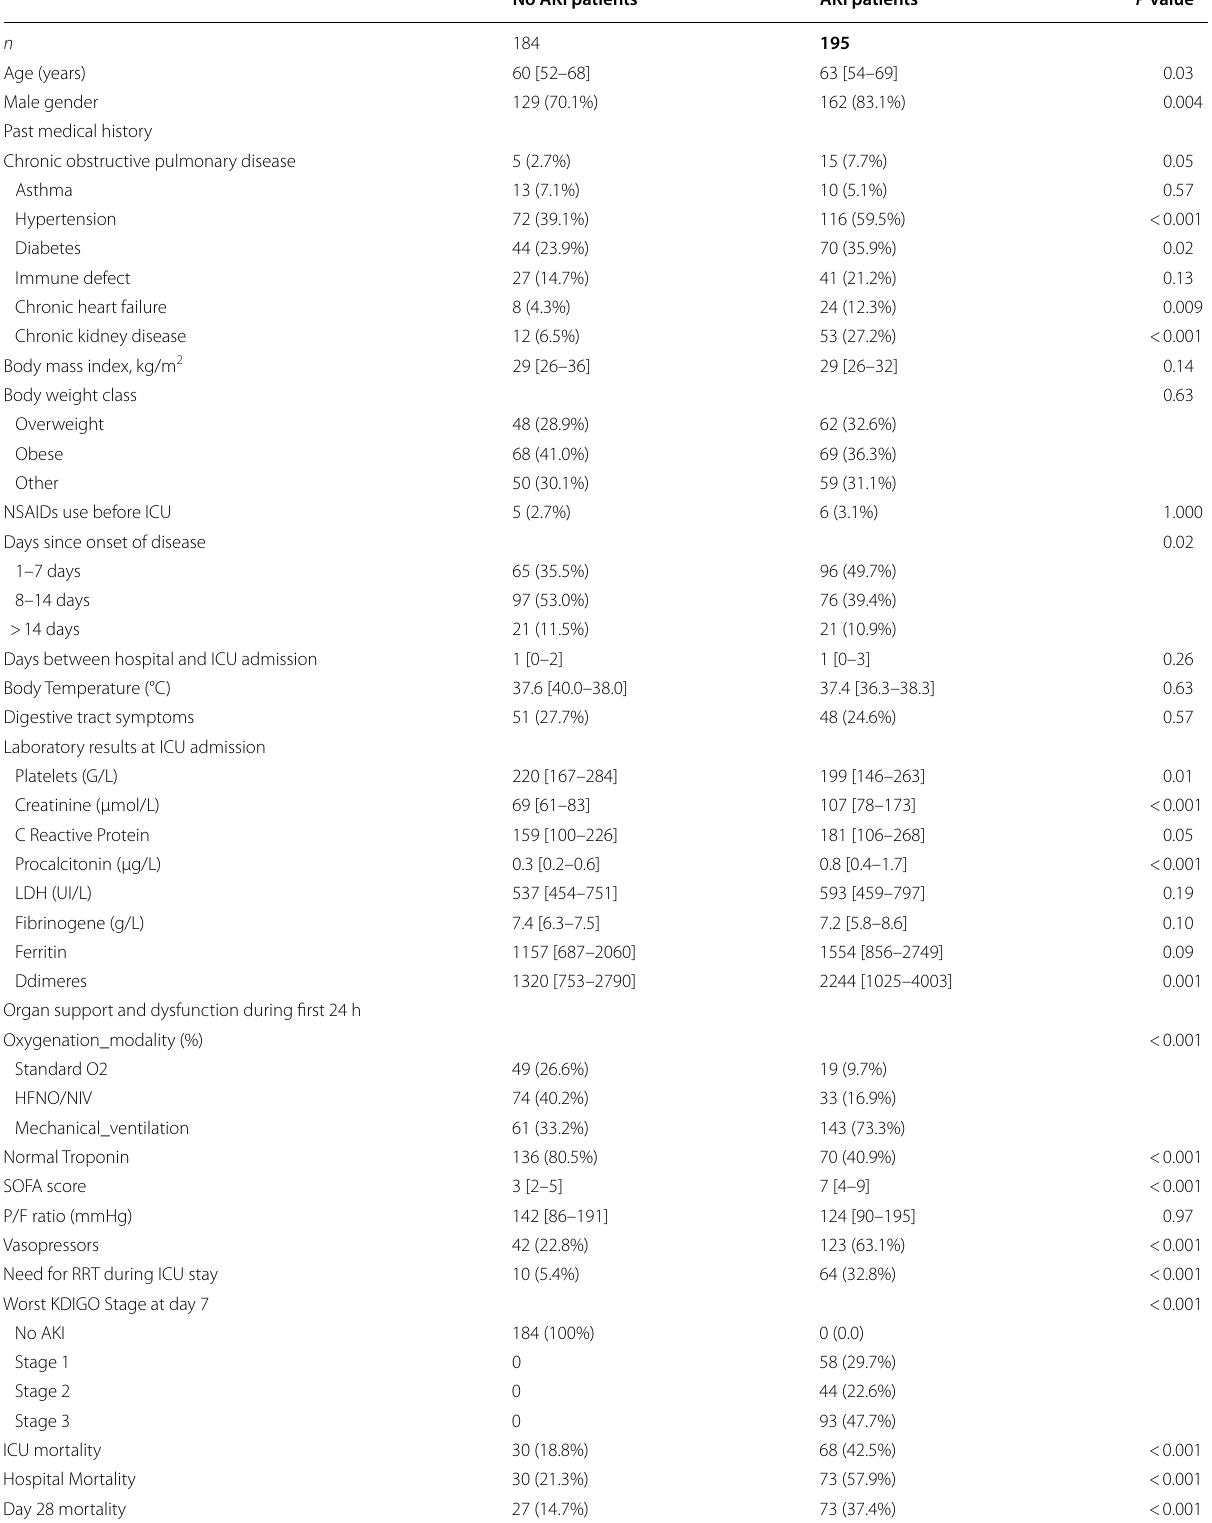
Table 1 Patients characteristics according to occurrence of